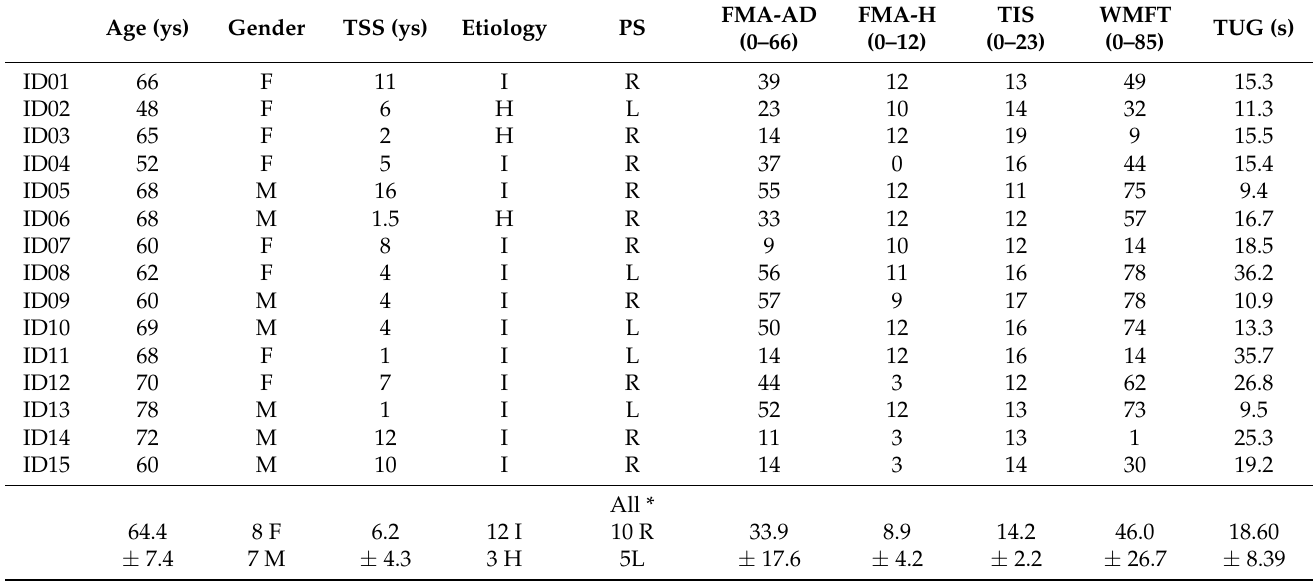
Table 1. Demographic data and clinical